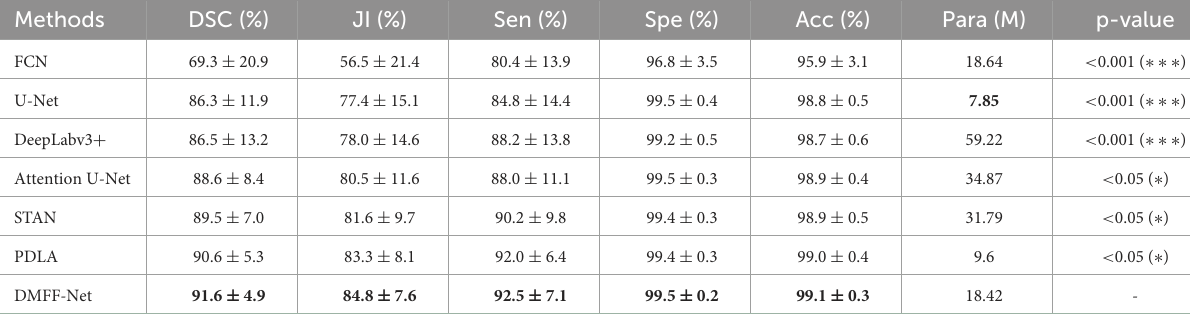
TABLE 2 Quantitative comparison of DMFF-Net with other medical image segmentation networks.